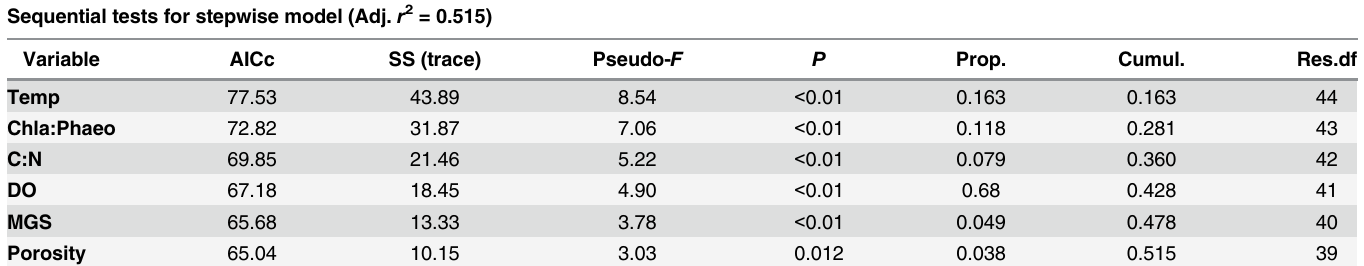
Table 3. Distance-based linear model (DistLM) of benthic fluxes against environmental drivers measured in the Salish Sea and NE Pacific in May/ July 2011, and September 2013. Sequential tests for stepwise model (Adj. r 2 = 0.515)